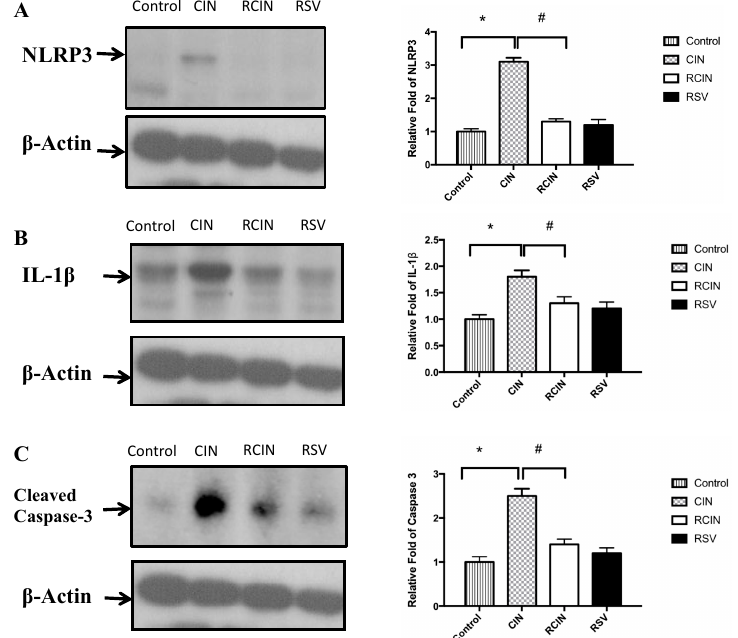
Figure 4. Western blot analysis of renal NLRP3, IL-1 β , and cleaved caspase-3. The expression of renal ( A ) NLRP3, ( B ) IL-1 β , and ( C ) cleaved caspase-3 increased after the injection of contrast medium in the CIN group, as assessed by Western blot analysis. Resveratrol significantly suppressed the expressions of cytokines in the RCIN group. *, #: p < 0.05 comparing the two groups. NLRP3 = NLR Family Pyrin Domain Containing 3, CIN: contrast-induced nephropathy, RCIN: pretreatment with resveratrol before CIN, RSV: resveratrol 30 mg/kg iv